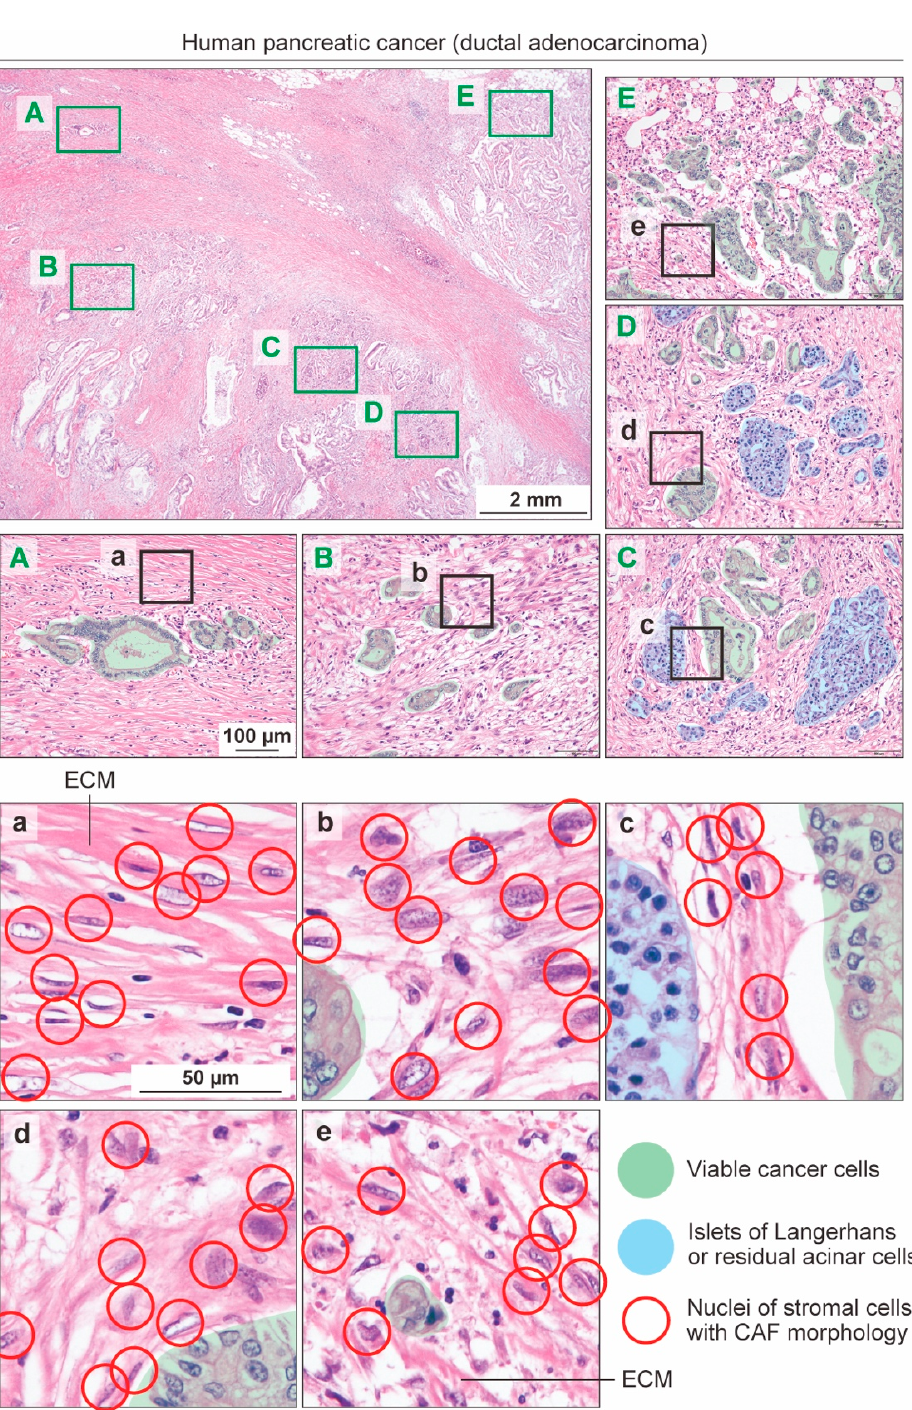
Figure 1. A representative histology of human pancreatic cancer. A low-magnification image of a tissue section of human pancreatic ductal adenocarcinoma (PDAC) stained with hematoxylin and eosin is shown in the top left panel. The areas outlined in green ( A – E ) are magnified in the adjacent right and lower panels. The areas outlined in black ( a – e ) are magnified in the lower panels with the same magnification. The circles represent stromal cells with CAF morphology. Viable cancer cell nests and islets of Langerhans/acinar cells are shaded in green and blue, respectively. ECM, extracellular